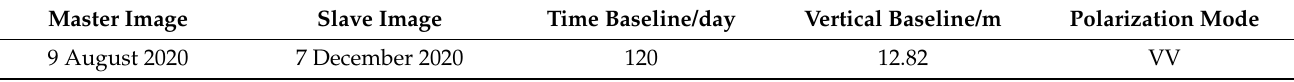
Table 1. Sentinel-1 SAR image information in the study